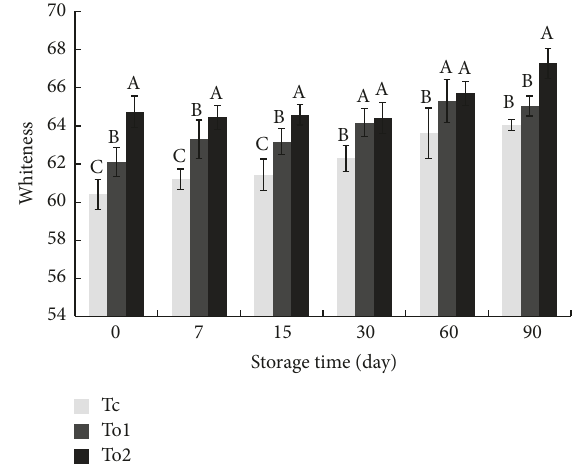
Figure 6: Changes in whiteness of silver carp surimi gel during frozen storage. Light grey: two washing cycles using ice water only (Tc), dark grey: first and second washing cycle using ice water containing 8mg/L ozone and ice water, respectively (To1); black: first and second washing cycle using ice water and ice water containing 8 mg/L ozone, respectively (To2). Different letters indicate significant difference among samples (Tc, To1, and